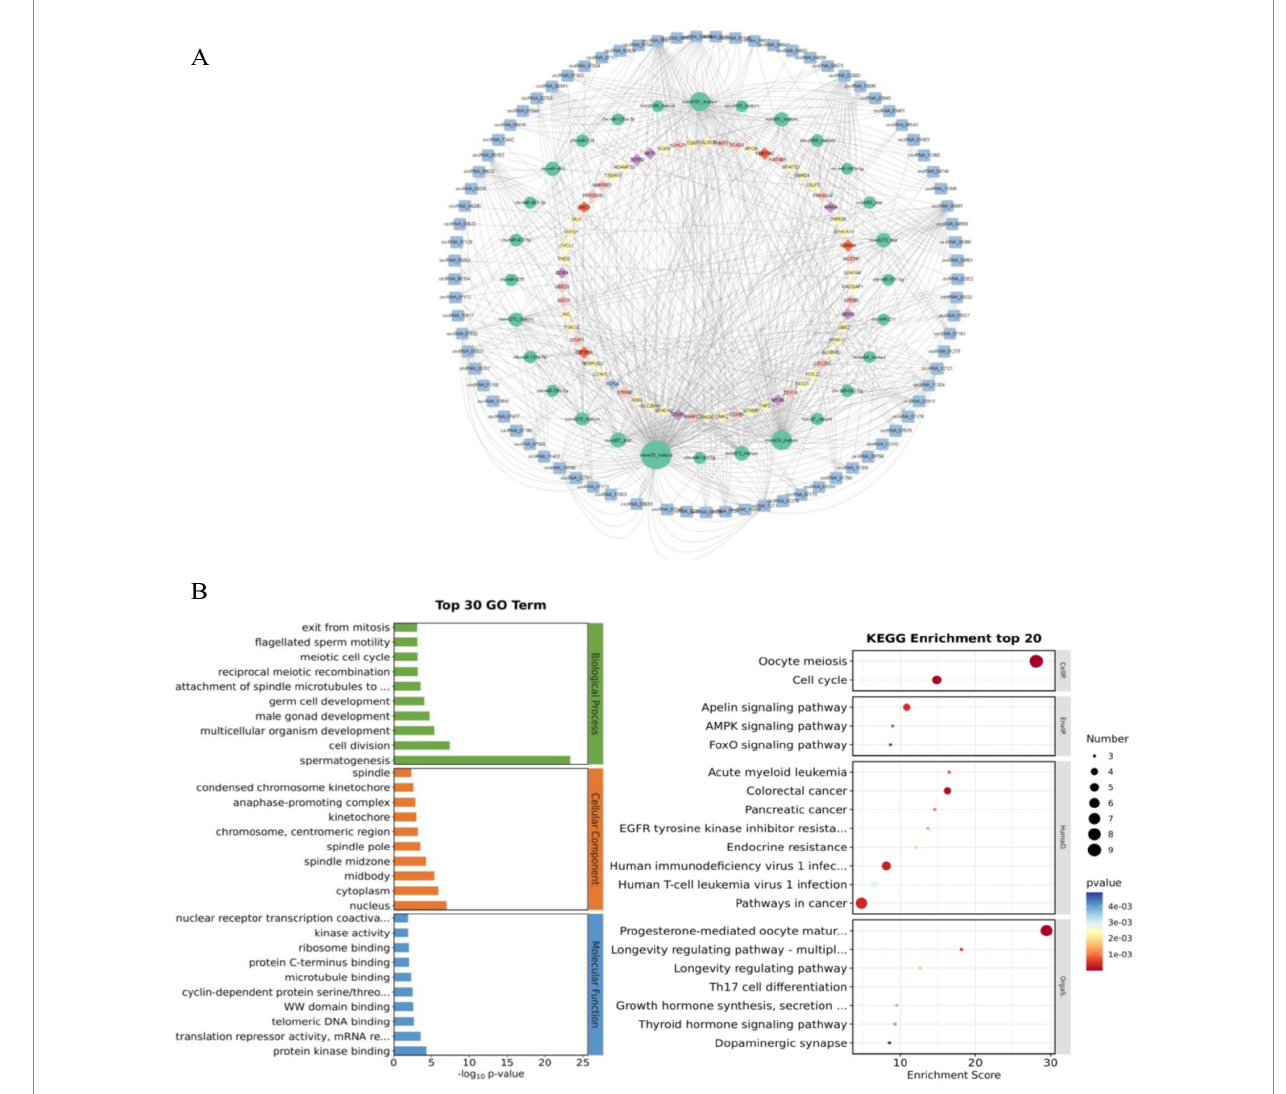
FIGURE 6 ceRNA network. (A) The ceRNA network related to testicular development and spermatogenesis in goats. (B) Enrichment analysis of genes in the ceRNA network by GO and